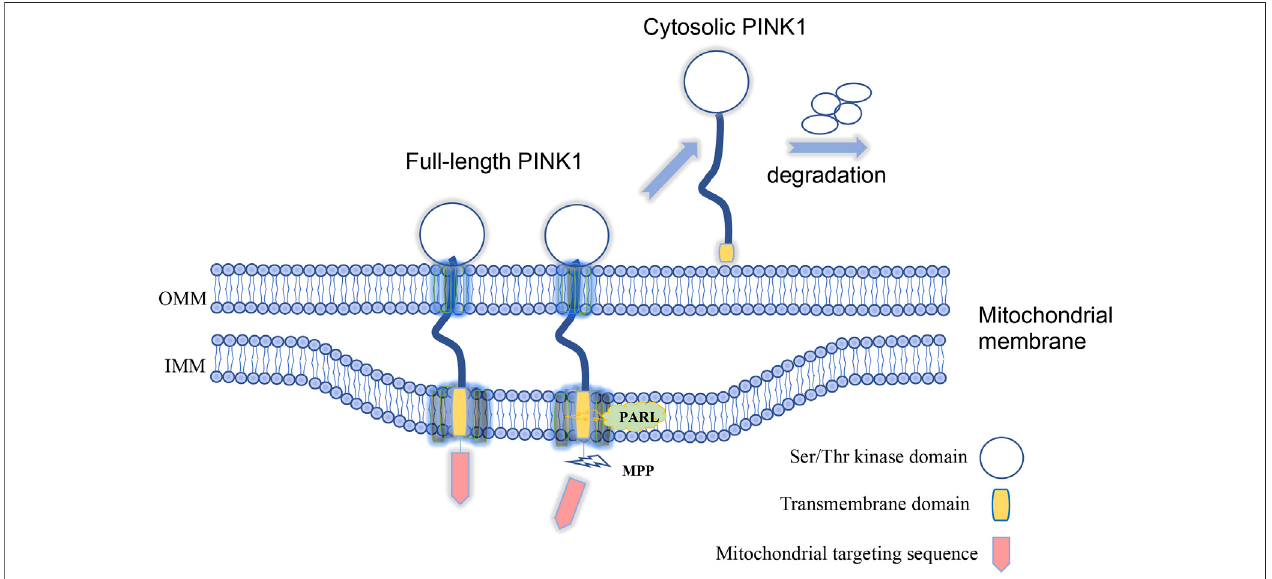
FIGURE1| Full-lengthPINK1isabletotargettomitochondriaandiscleavedbyproteasestogeneratecytosolicformofPINK1uponmitochondriadamage.Lackof in vivo evidence for PINK1-mediated mitophagy.